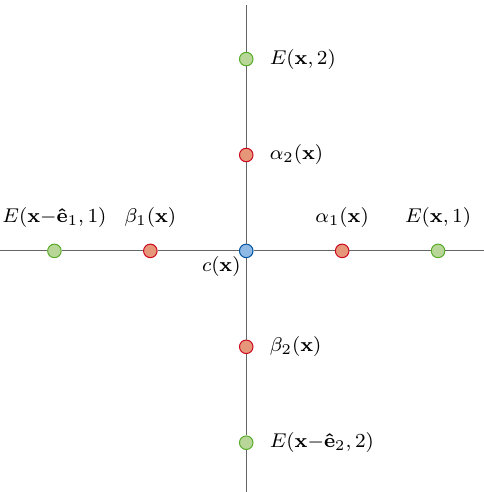
Figure 1: Visual representation of the construction detailed in (115) to (118). For clarity, we show only the auxiliary modes that are newly introduced and the electric fields. On each vertex site x an auxiliary fermionic Majorana mode c ( x ) (blue circle) ( x ) and β ( x ) (red circles) are introduced below is defined. The auxiliary modes α i i and used in equation (124). The electric fields on the respective links are shown as green